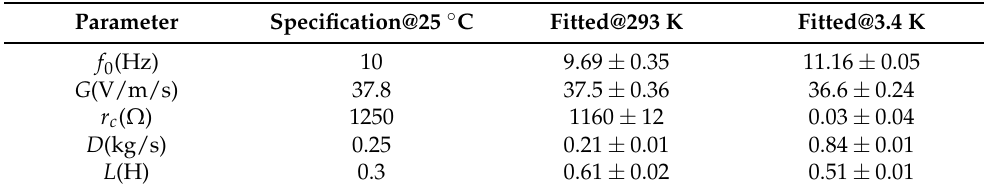
Table 1. Parameters fitted from Equation (2), including room temperature calibration and cryogenic temperature calibration. The error bars of the data are calculated from 14 data